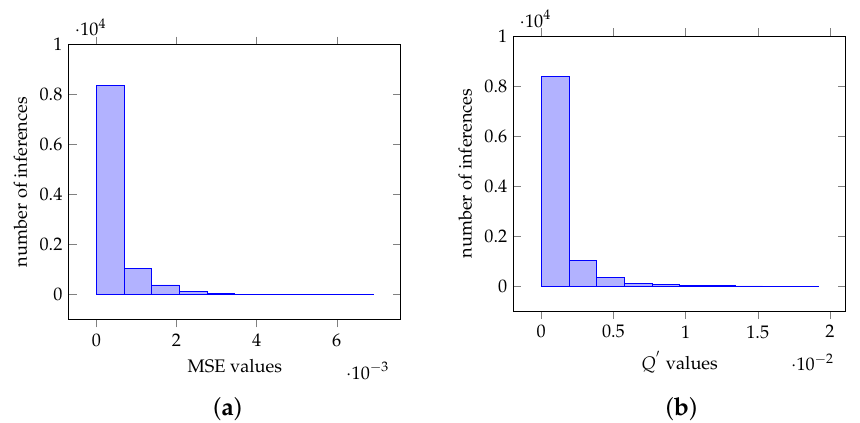
Figure 8. Values obtained from imagenet image VGG-19 net classification for 1000 classes. ( a ) Histogram of the MSE values. ( b ) Histogram of the Q (cid:48) values.